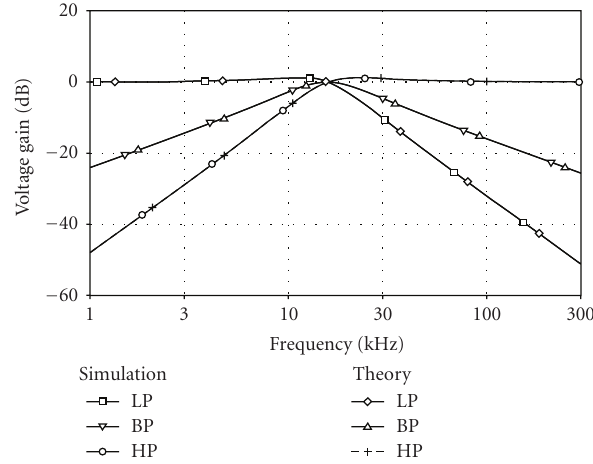
and ε n ( | ε n | (cid:2) 1) is the current-tracking error from n ter- minal to z terminal, and β = 1 − ε v and ε v ( | ε v | (cid:2) 1) is